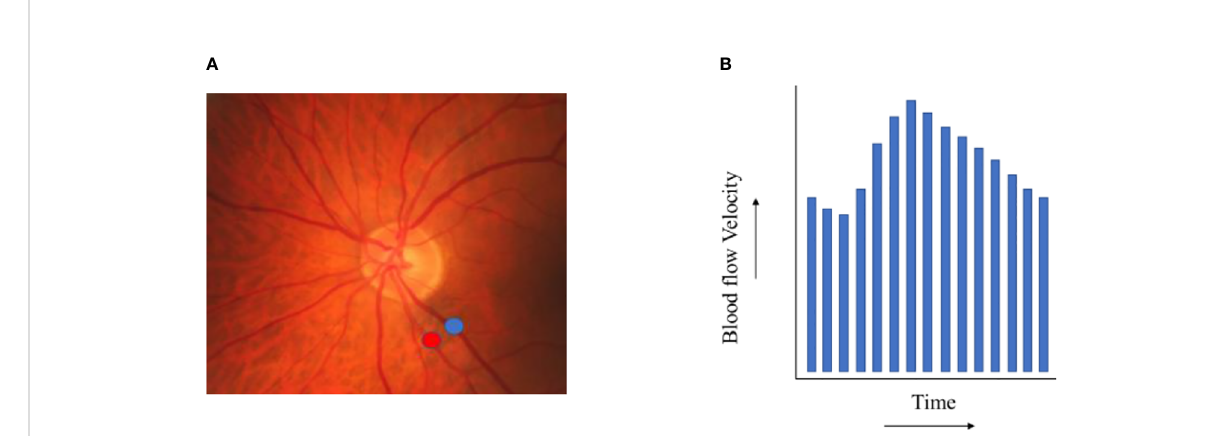
FIGURE 2.5 Retinal blood fl ow. (A) shows exemplary locations on a fundus photo where retinal arteriolar (red) and venular (blue) blood fl ow velocity can be assessed. (B) depicts the results of a retinal blood fl ow velocity measurement (during one heart beat).